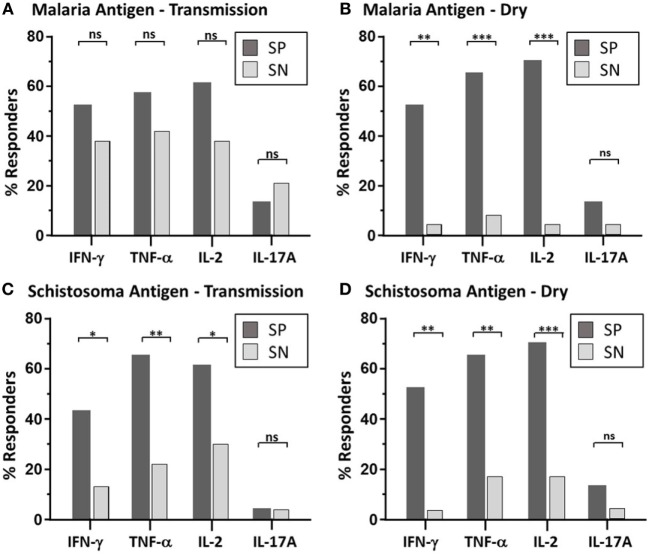
Maintenance of parasite-specific memory response—depicted is the bar graph representation of the percent of responders with significant memory response, as defined by CD4 T cell-derived expression to each individual cytokine (IFN-γ, TNF-α, IL2, and IL-17A), after malaria antigen pool (apical membrane antigen 1 and merozoite surface protein 1) (A,B) or Sh antigen pool (soluble egg antigen and soluble worm antigen protein) (C,D) stimulation. Peripheral blood mononuclear cells acquired from schistosoma-positive (SP: dark bar) or -negative (SN: light bar) Malian children aged 4–14 years acquired at the time of acute malaria during the transmission season and again, 6 months later, during the dry season were stimulated with parasite antigen and results were measured by flow cytometry after gating on CD19−CD14−CD3+CD8−CD4+ T cells after live/dead discrimination. χ2 results using Mantel–Haenszel analysis was performed between SP vs. SN children with statistically significant quantities of cytokine production after antigen stimulation. P value significance set at *<0.05; **<0.001; ***<0.0001. Not significant, ns. The dot plot depiction of the individual cytokine net percentage of response is depicted in Figure S2 in Supplementary Material.